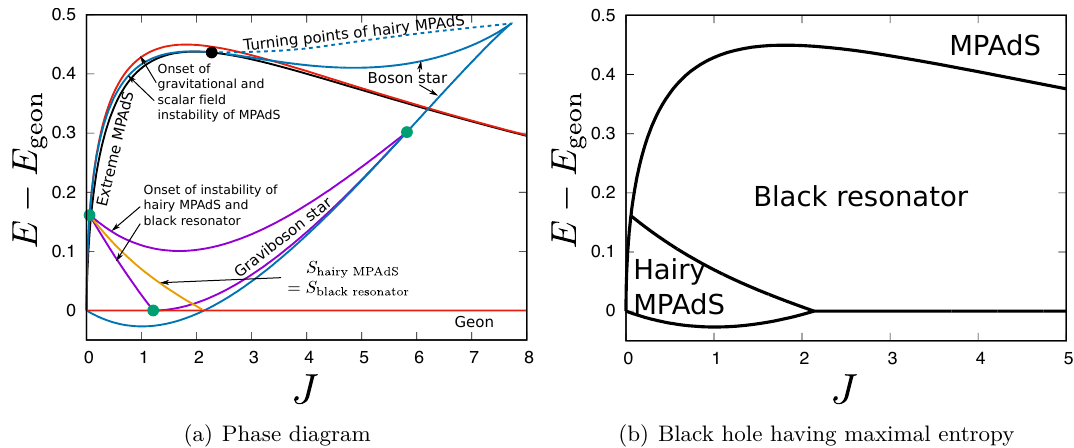
Figure 6 . (a) Phase diagram of asymptotically AdS solutions in Einstein-multiplet complex scalar fields system for j = 9 / 2 . (b) Black hole having maximal entropy among the MPAdS, hairy MPAdS, black resonator, and hairy black resonator for j = 9 / 2